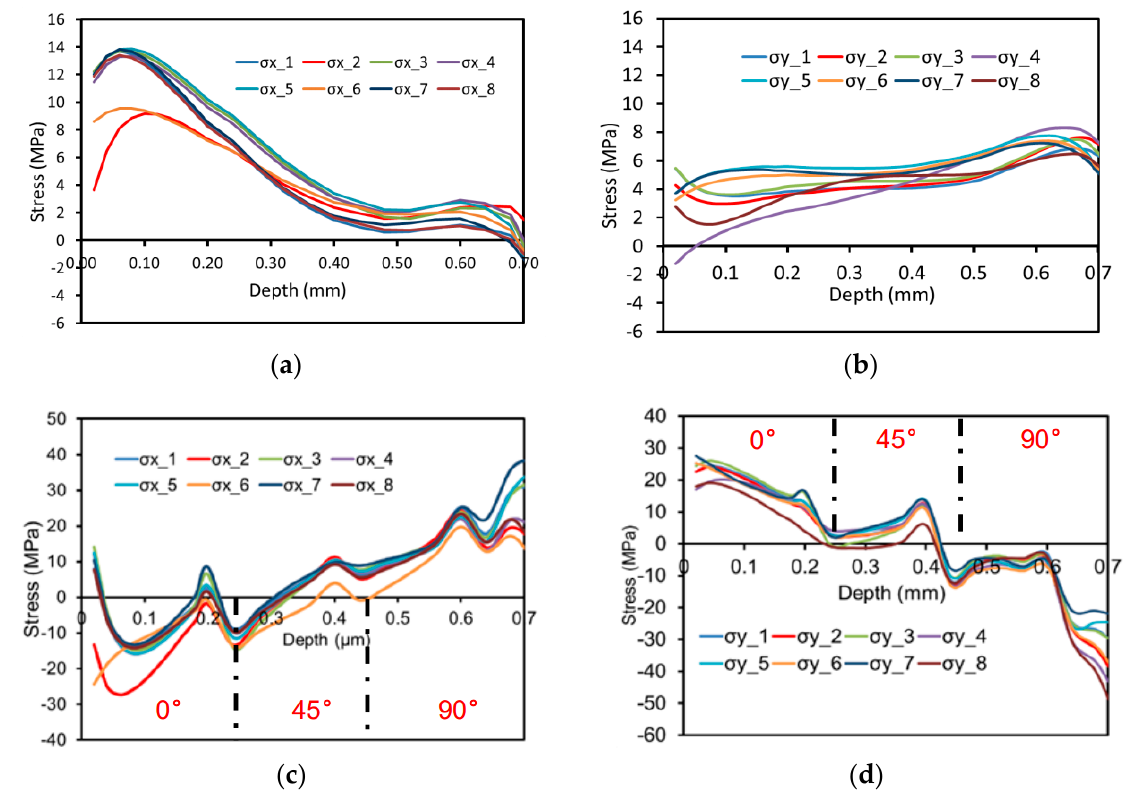
Figure 10. Depth ‐ dependent residual stresses σ x ( a , c ) and σ y ( b , d ) of uni ‐ ( a , b ) and multidirectional Figure 10. Depth-dependent residual stresses σ x ( a , c ) and σ y ( b , d ) of uni- ( a , b ) and multidirectional ( c , d ) CFRP, respectively, for 8 different combinations of strain gage directions. ( c , d ) CFRP, respectively, for 8 different combinations of strain gage